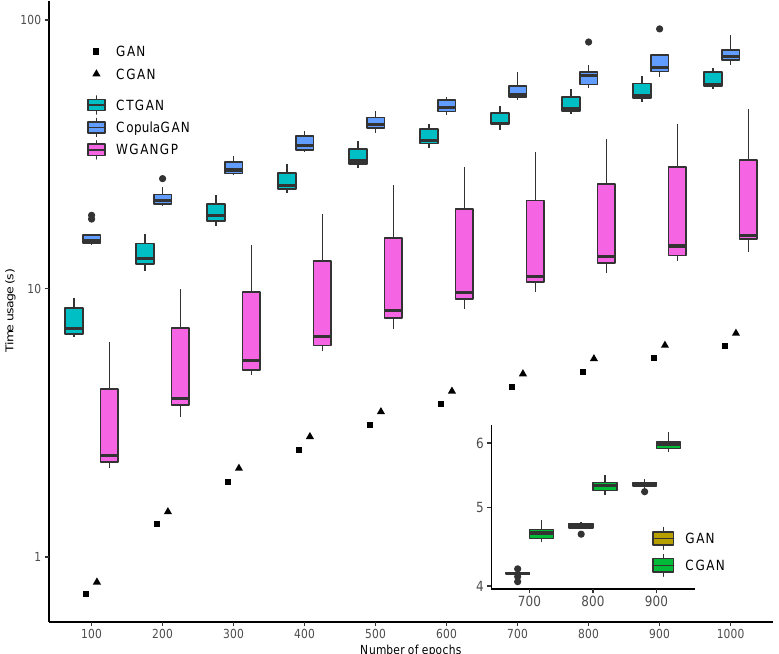
Figure 6. Time usage (seconds) of the GAN variants for the generation of synthetic data over different number of epochs using the BCW dataset. For illustrative purposes, the GAN and CGAN data points are represented by squares and triangles in the main panel. The variation in time usage of GAN and CGAN for epochs (700–900) are shown in the inset.